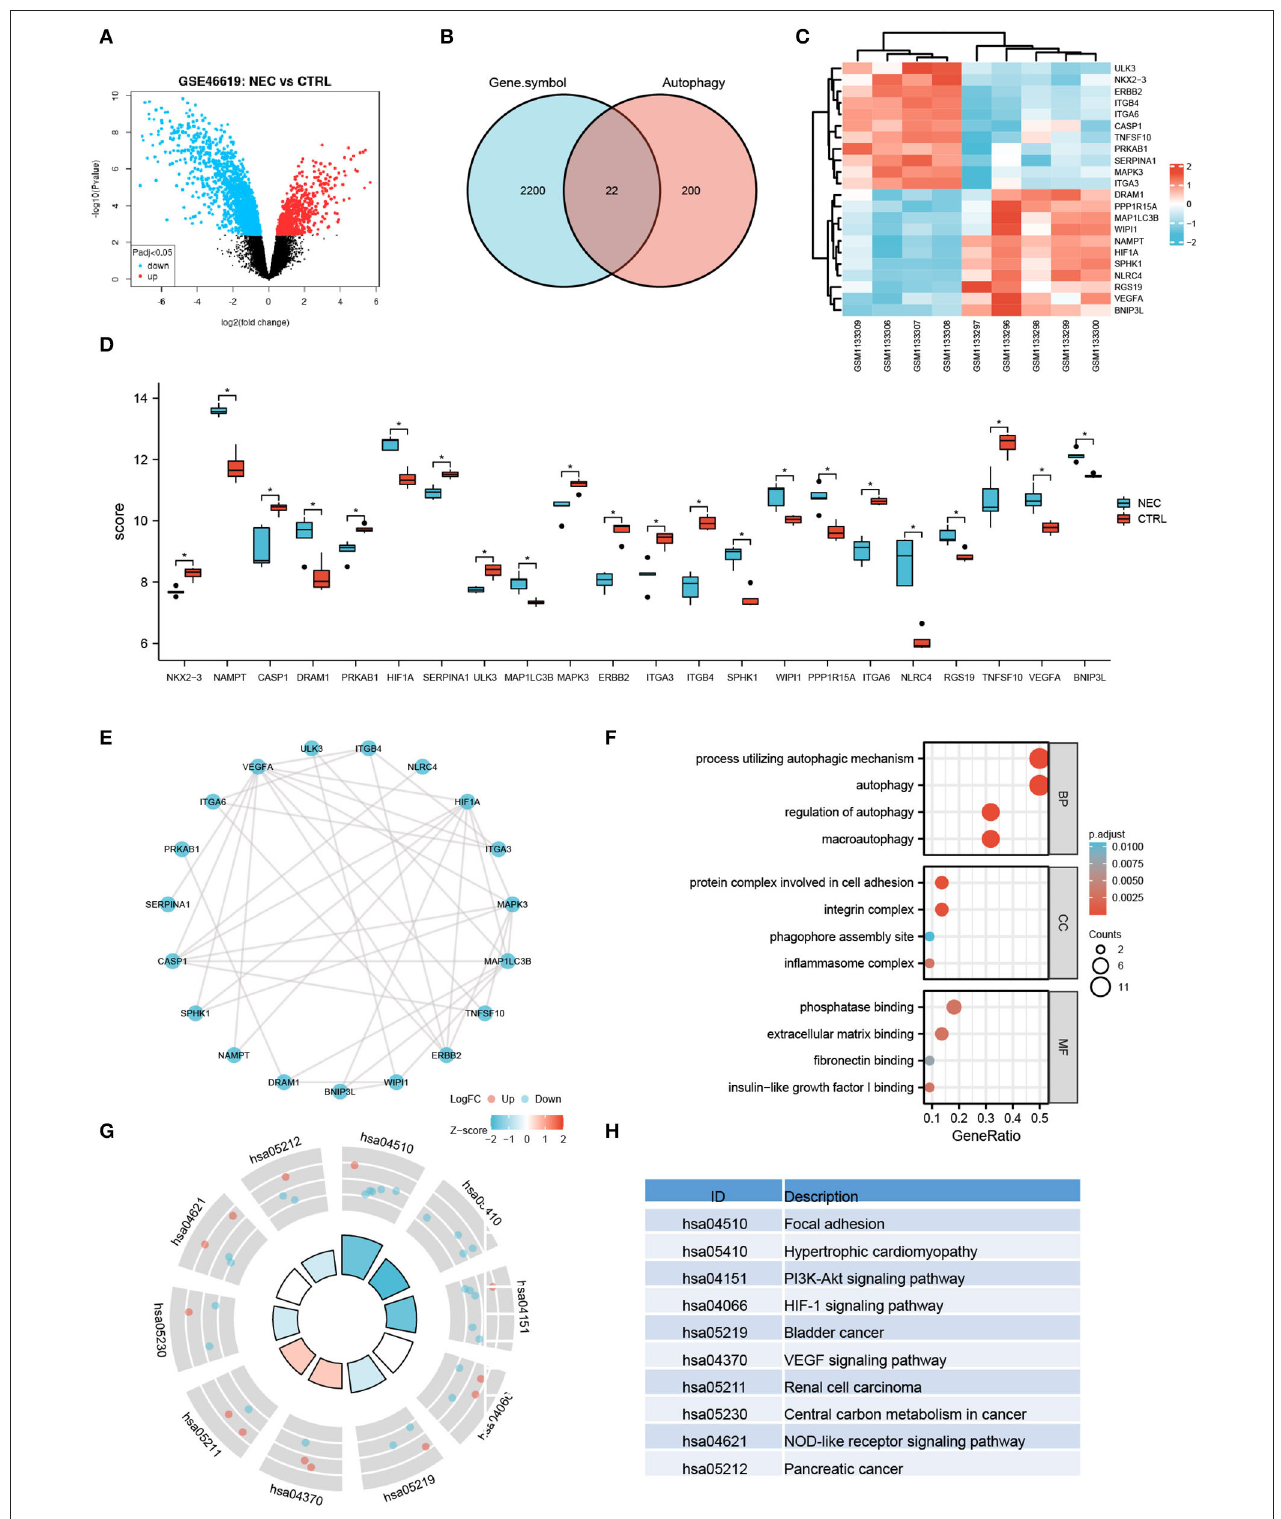
FIGURE 3 | Autophagy-related differentially expressed genes in human NEC from dataset GSE46619. (A) Volcano plot of the DEGs in human NEC and CTRL samples from GSE46619. The red dots represent the significantly upregulated genes and the blue dots indicate the significantly downregulated genes. (B) Venn image of arDEGs. (C) A heatmap of the 22 arDEGs in human NEC and CTRL tissues. (D) The boxplot of 22 arDEGs in human NEC and CTRL tissues. (E) The PPI analysis of the 22 arDEGs. (F) Gene Ontology enrichment analysis of 22 arDEGs. (G,H) Kyoto Encyclopedia of Genes and Genomes enrichment signaling pathway analysis of 22 arDEGs. * p <